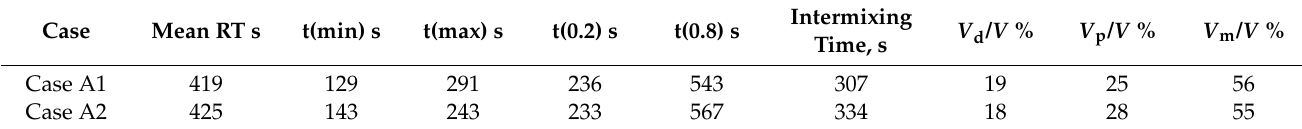
Table 5. RTD analysis for Case B1 and Case B2.